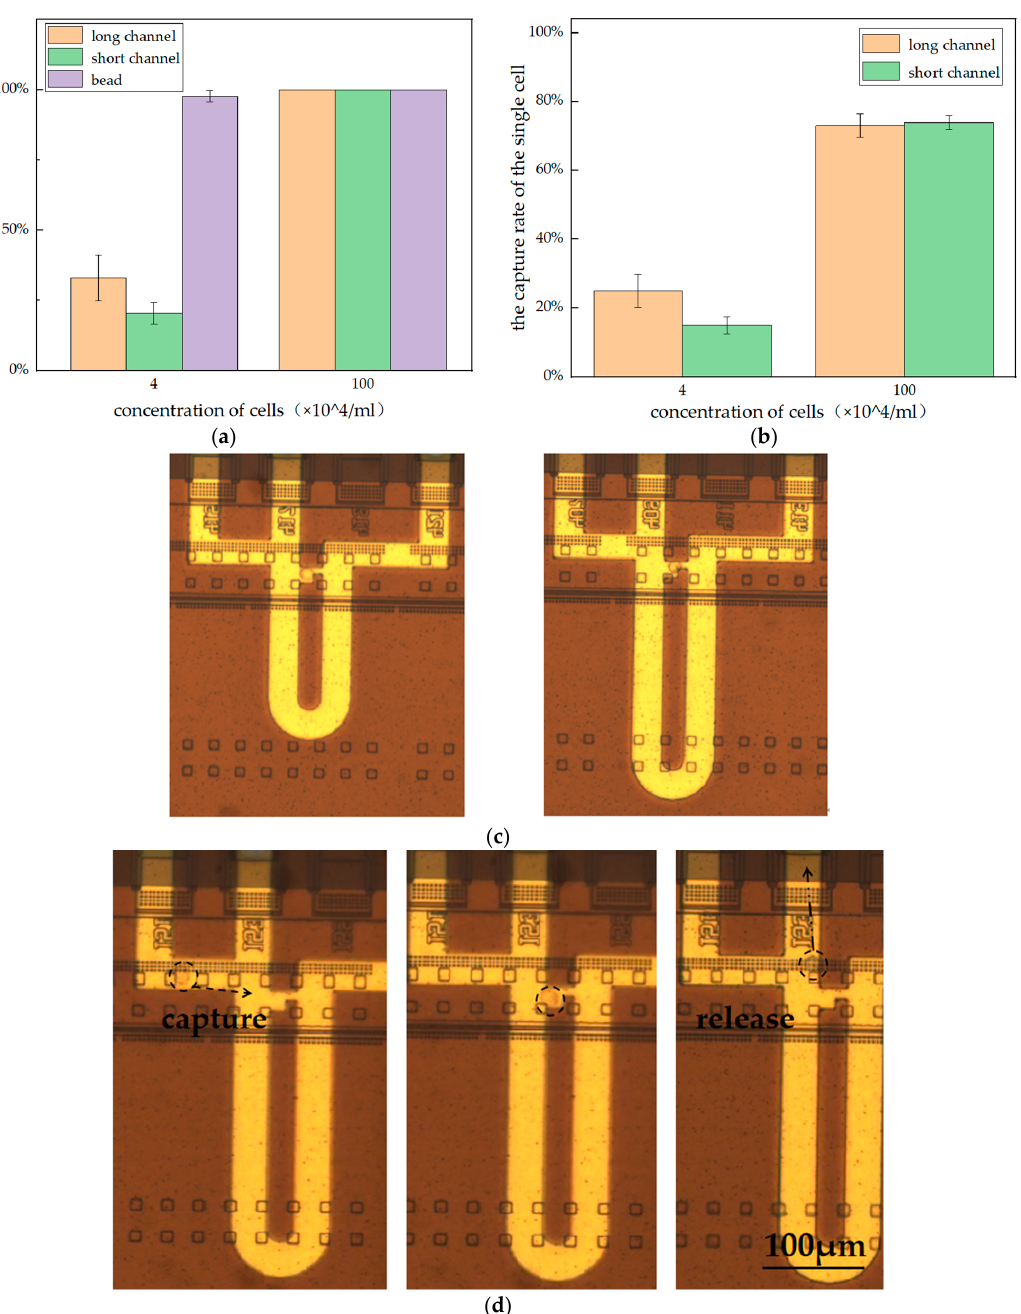
Figure 9. ( a ) Comparison of capture rates at two different cell concentrations; on the far right is the capture rate of the beads at the same concentration. ( b ) Multicellular capture occurred frequently at high concentrations; ( c ) image of a microfluidic chip that captured a single cell; ( d ) the process of cell capture, from capture to release.